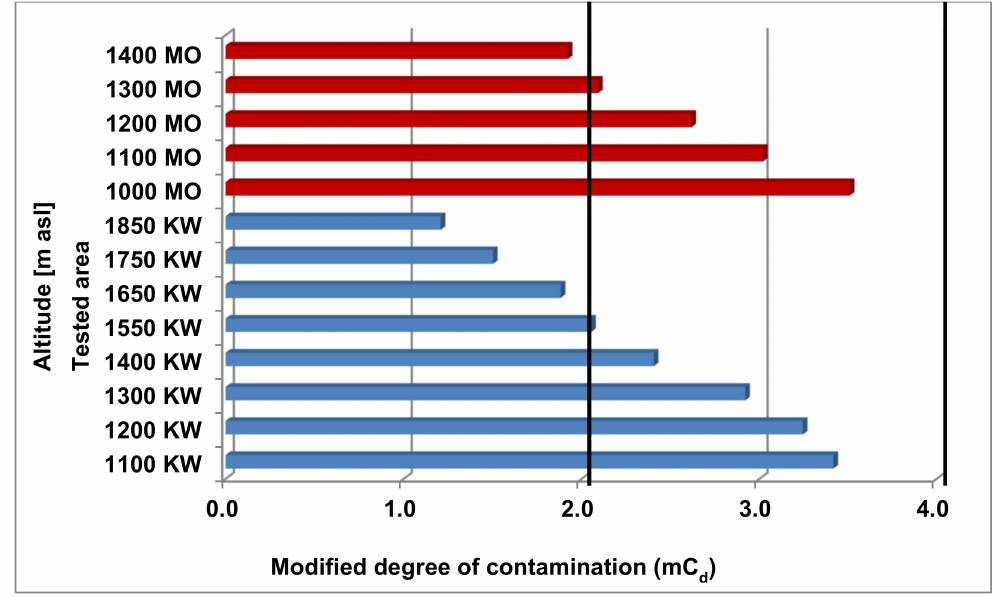
Figure 2. Histogram of the modified degree of contamination (mC d ) using Cd, Cr, Cu, Ni, Pb, and Zn in soil samples from the Tatra National Park. The two vertical lines represent the boundaries between low (mC d < 2) and moderate (2 ≤ mC d < 4) degrees of contamination. Morskie Oko tested area is marked in red, Kasprowy Wierch tested area is marked in